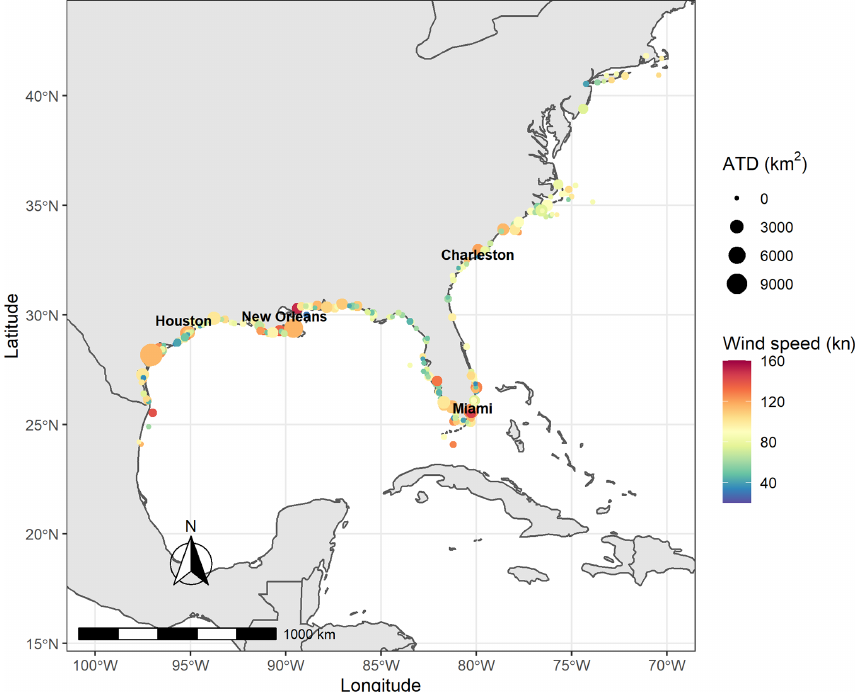
Figure 2. Map of hurricane landfall locations 1900–2017 with corresponding wind speed (kn) and area of total destruction